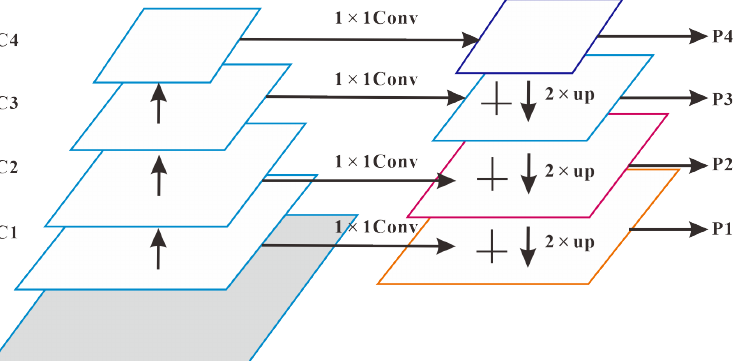
Figure 1. Multi-scale feature integration through the FPN model. Features are extracted from each layer, and a map is formed through up-sampling and horizontal connection